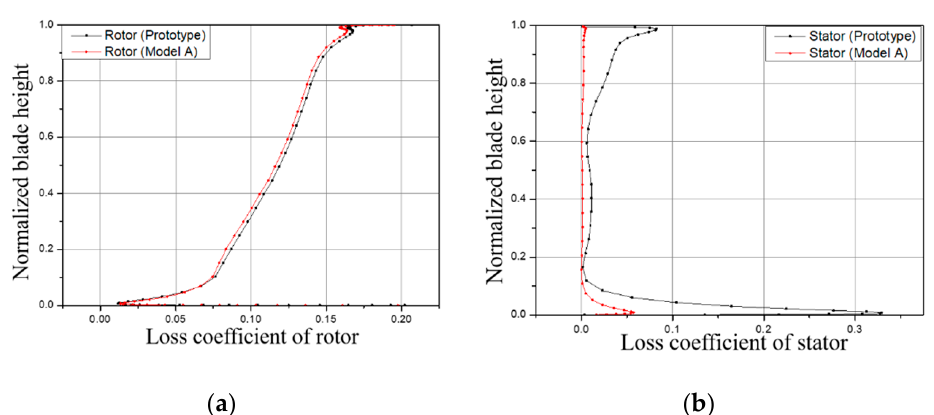
Figure 10. Loss coefficient distributions of the rotor and stator: ( a ) loss coefficient of rotor; ( b ) loss coefficient of stator.